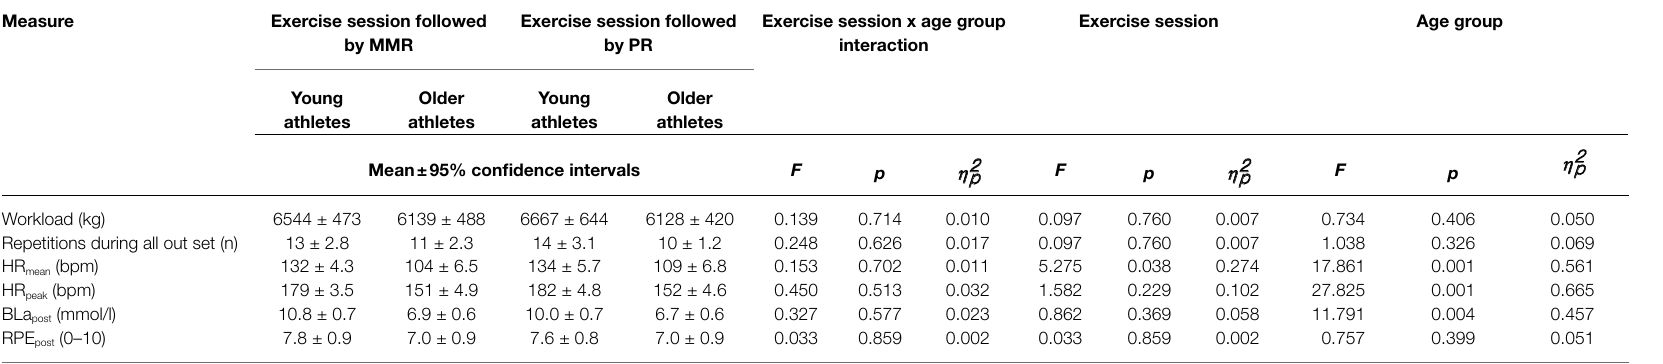
TABLE 4 | External and internal squat training loads as well as results of the two-way mixed ANOVA, employing the within-subject factor squat exercise session and the between-subject factor age group. Measure Exercise session followed Exercise session followed by MMR by PR